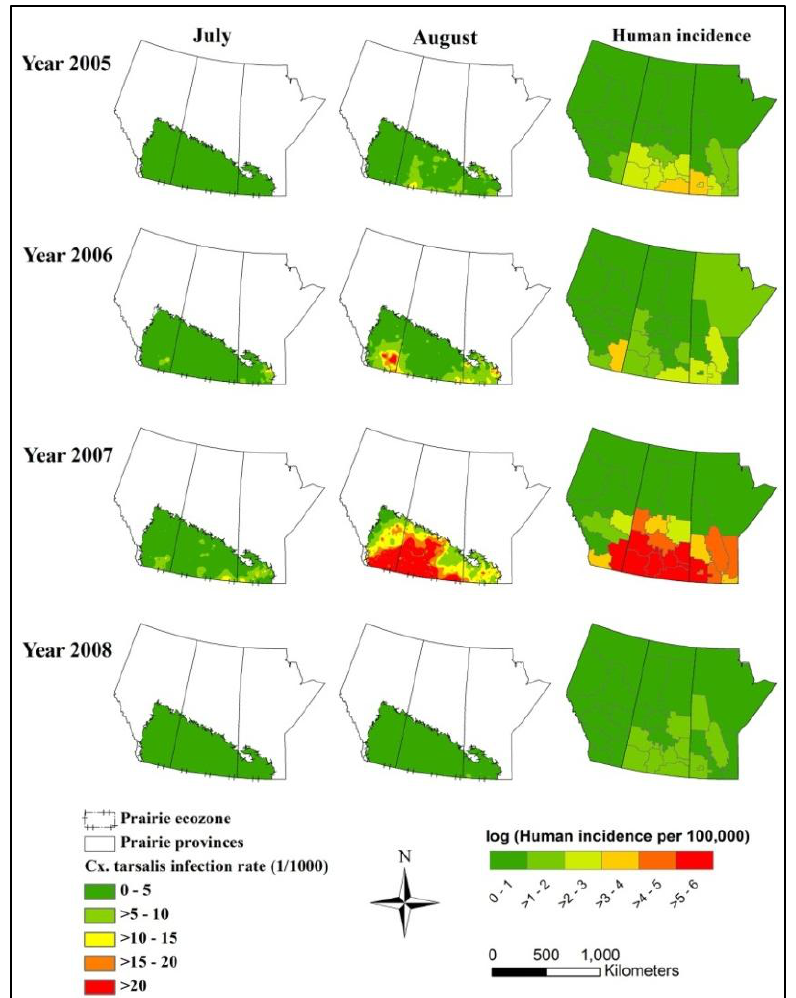
Figure 4. Maps of predicted WNV infection rate in female Cx. tarsalis per 1,000 in July and August 2005–2008 in the Canadian prairies and log transformed human incidence (cases per 100,000 individuals) for each health region in the entire WNV transmission